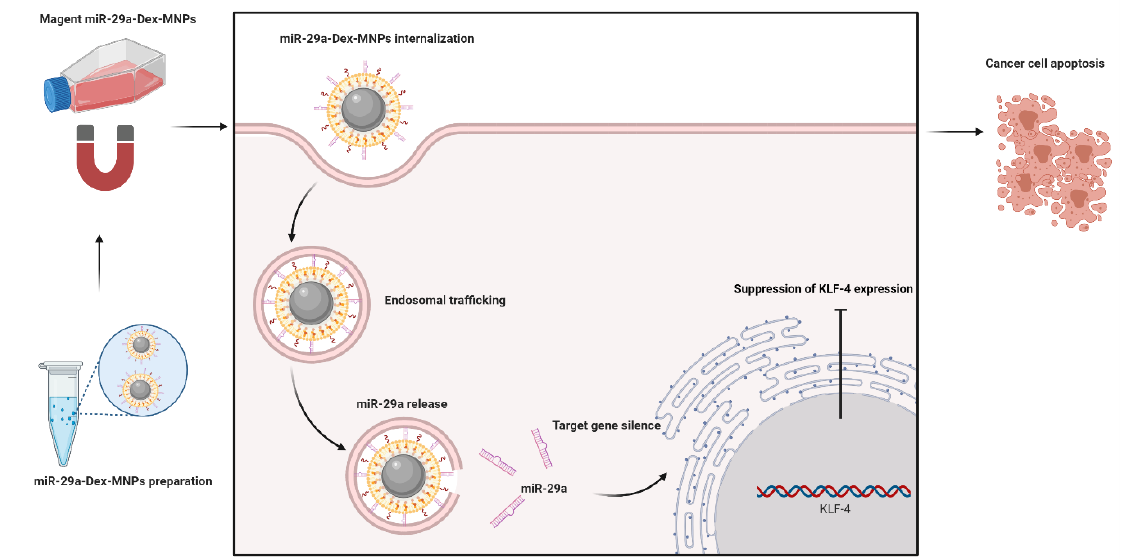
Figure 5. Dextran used in RNA interference therapy.